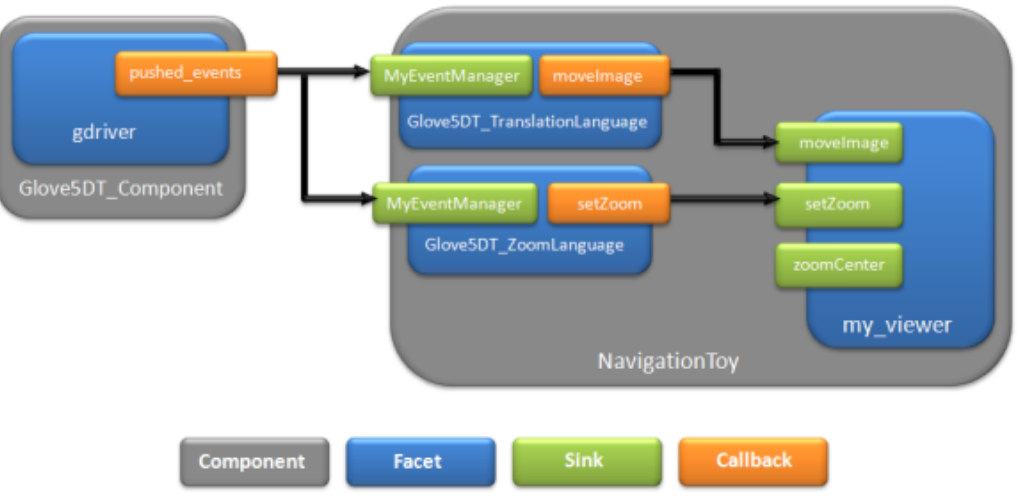
Fig. 1. OpenInterface